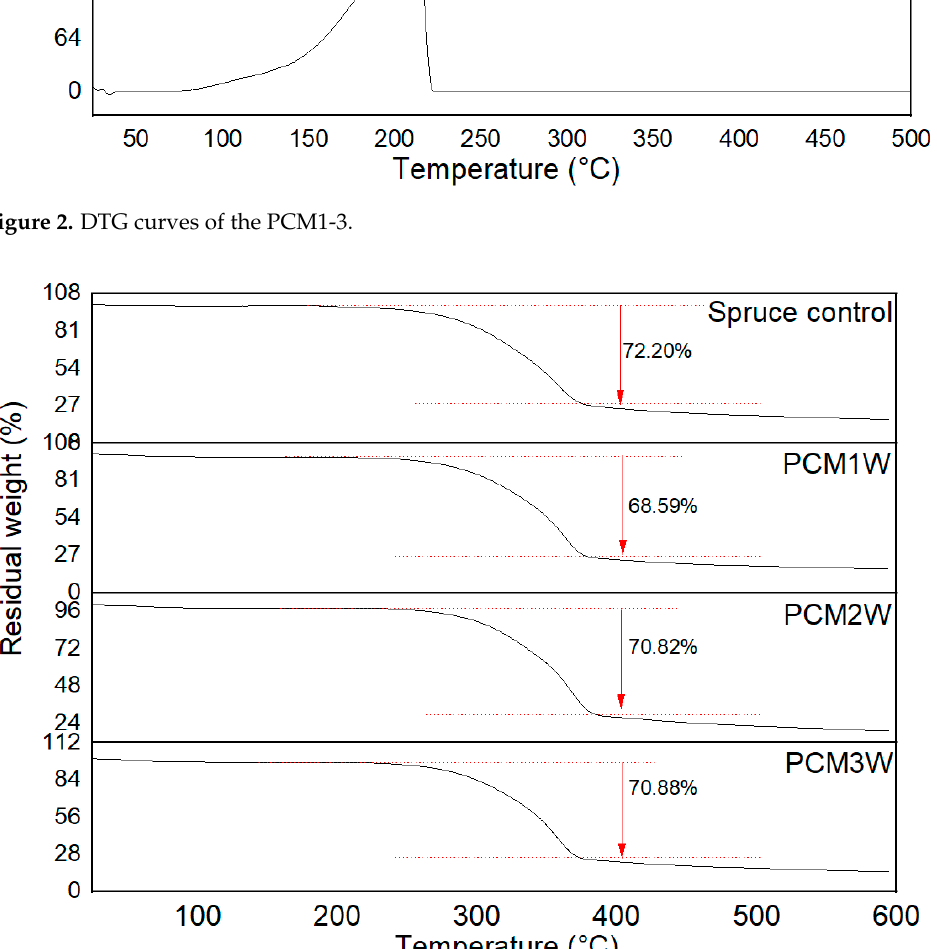
Figure 4. DTG curves of the PCMW1-3. It appears that the PCMs in Figures 1 and 2 and Table 2 decomposed at low tem- peratures, specifically at 200 °C, and lost all of their weight at this temperature. This suggests that the materials were not stable at this temperature and may not be suitable for certain applications. The wood samples impregnated with PCMs were found to dete- riorate at higher temperatures, in contrast to the PCMs alone, which decomposed at lower temperatures. This suggests that the addition of PCMs to the wood samples may